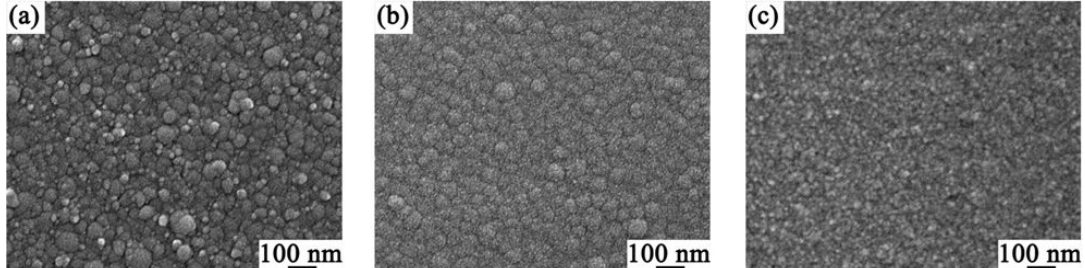
Figure 4. Top-viewed SEM images of (a) a SiO